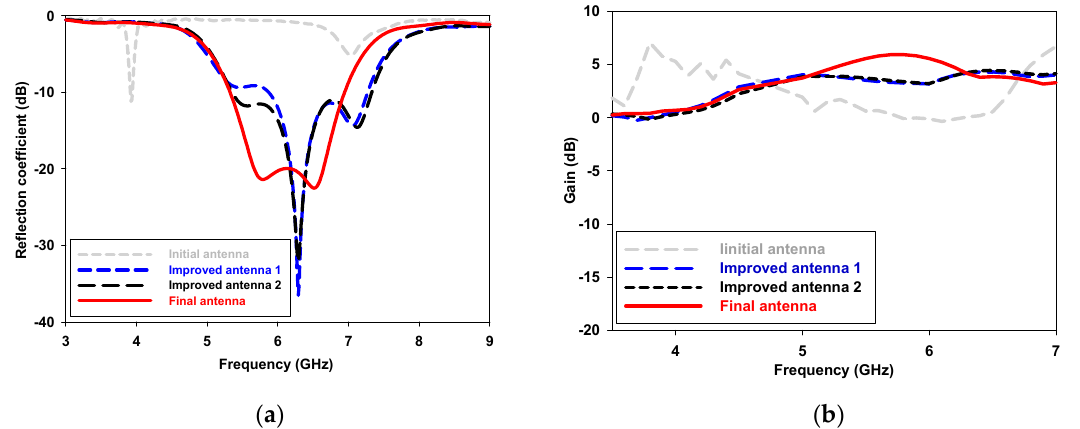
Figure 4. Simulated reflection coefficient and max gain of different antennas: ( a ) Reflection coefficient, ( b ) Max gain.